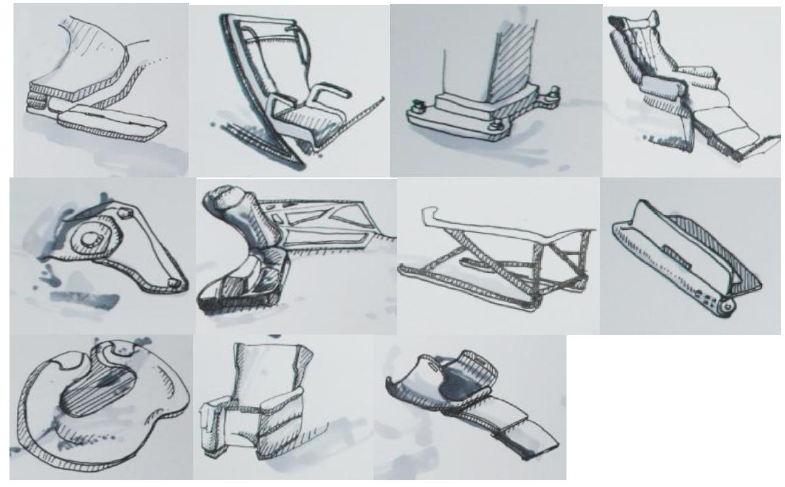
Figure 1. Sketches of the design concept.